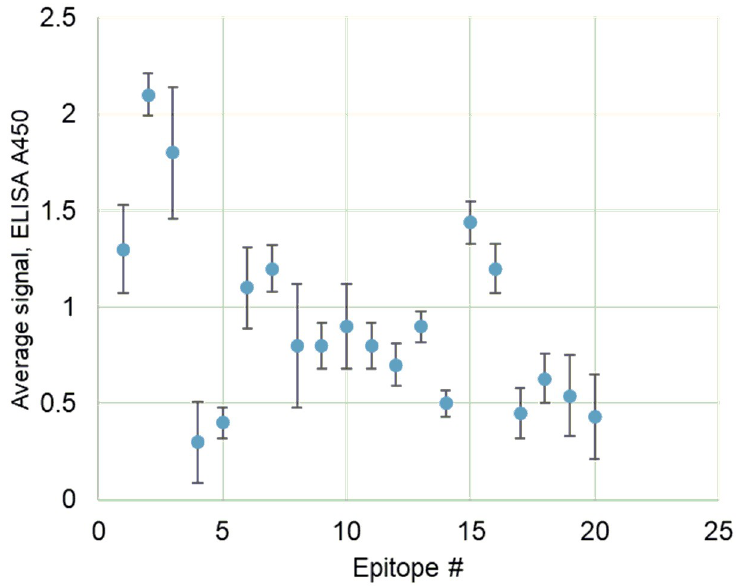
Fig 2. Mean response to epitopes E1-E20 in RA samples, n = 70. Each sample has been analyzed in duplicate, and in two independent ELISA experiments, with CV below 5% being considered as a reliable result.